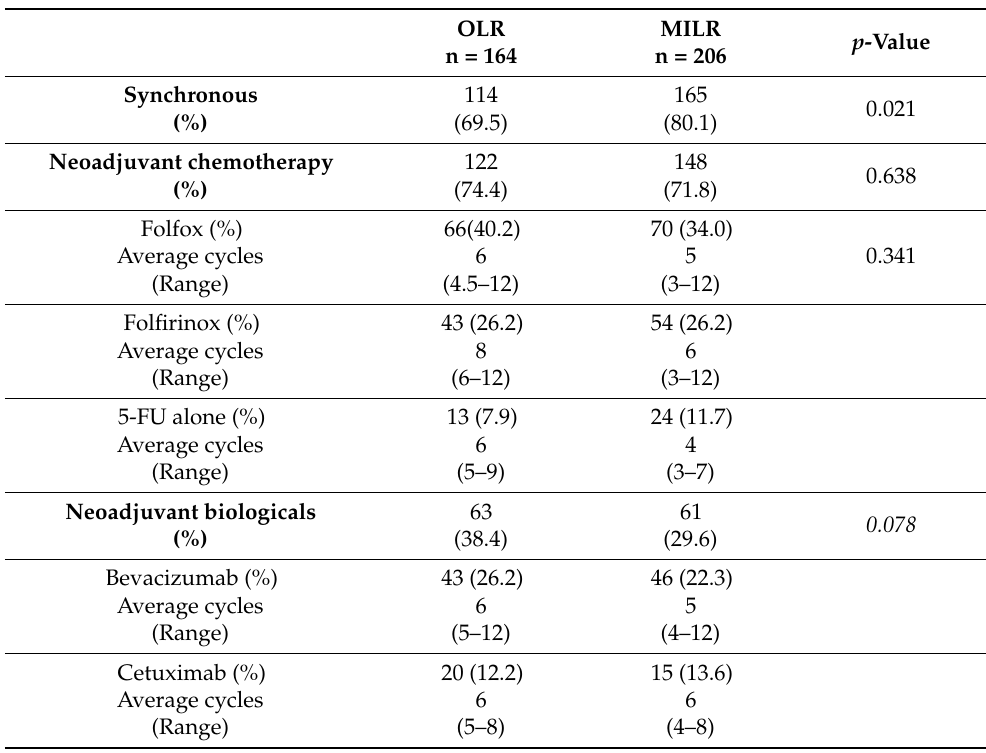
Table 2. Oncological factors after propensity score matching of all open liver resections (OLRs) compared to all laparoscopic liver resections (LLRs) and robotic liver resections (RLRs) combined, including the type of neoadjuvant chemotherapy and biological